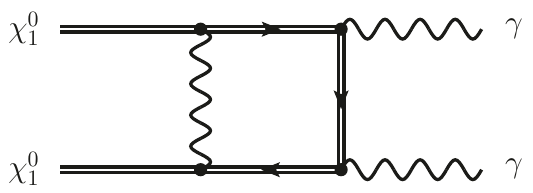
Figure 1 . Diagram computed in the potential region to subleading power to subtract the Som- merfeld e(cid:11)ect from the (cid:12)xed-order